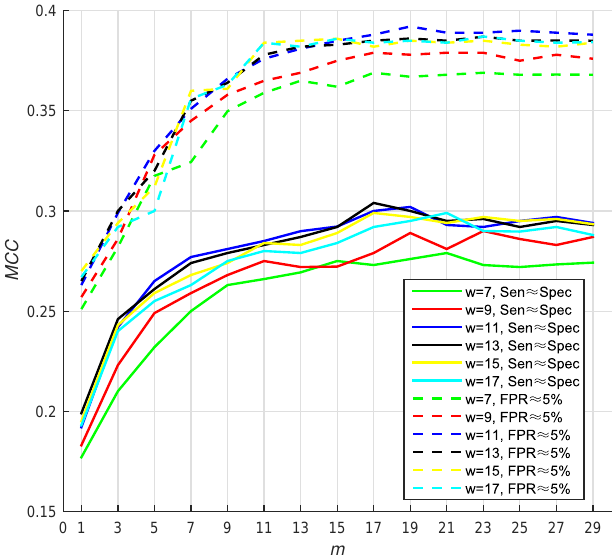
Figure 3. The MCC (Matthew Correlation Coefficient) of PSSM (Position Specific Scoring Matrix)- MLAB (Multi-scale Local Average Blocks) with different sizes of sliding window and numbers of base classifiers (WSRC (Weighted Sparse Representation based Classifier),